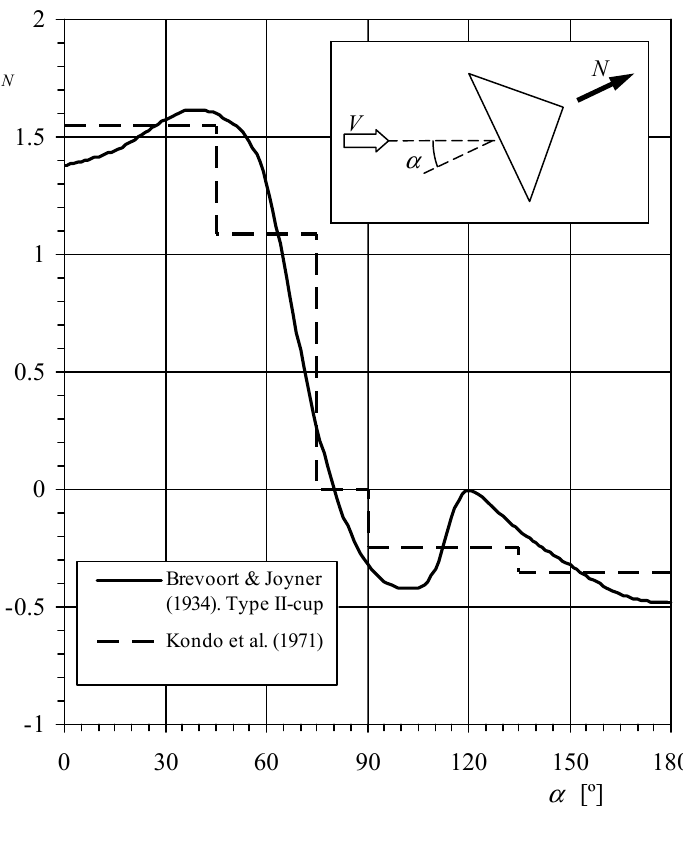
Figure 2. Normal aerodynamic force coefficient, c cup plotted as a function of the wind direction with respect to the cup, α